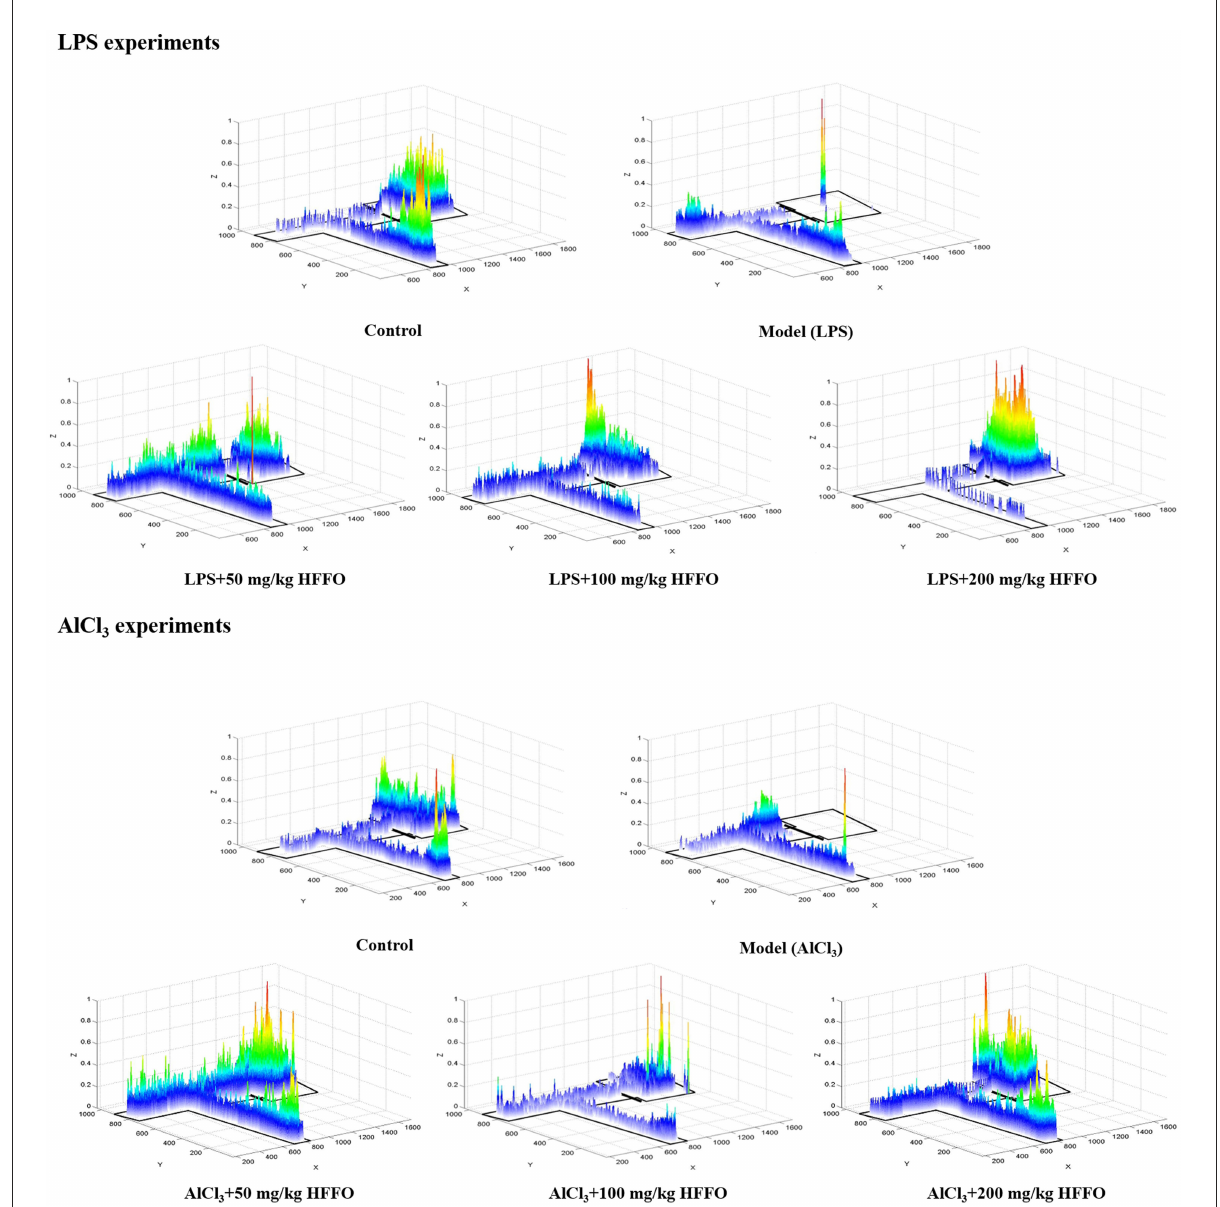
FIGURE2 Heatmaps of zebrafish activity in the T-maze on the fifth day. The X-axis and Y-axis in the figure represent the motion trajectory of zebrafish, while the Z-axis represents the residence time of zebrafish. The higher the Z-axis, the longer the residence time of zebrafish at a certain point.